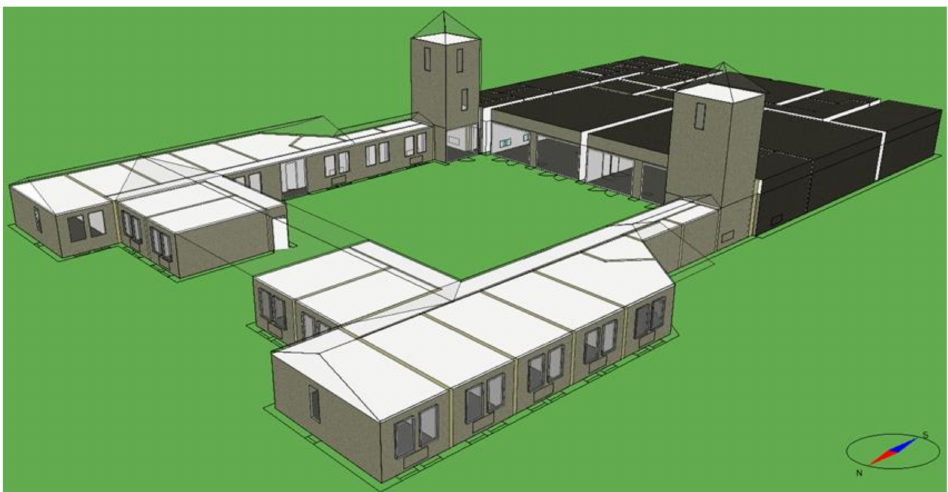
Figure 3. 3D model of the analysed CEEE’s building of the Silesian Botanical Garden, Mikoł ó w, Poland, created in the IDA ICE